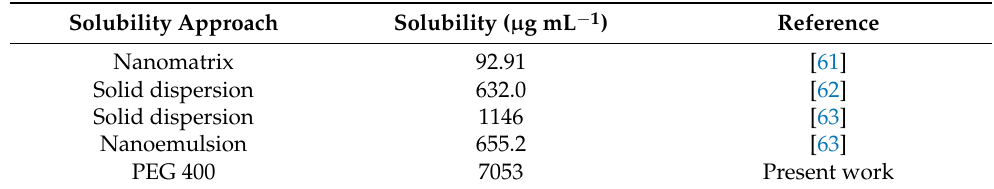
Table 3. Comparison of current solubility data of FTX in PEG 400 with different approaches of FXT solubility enhancement at 298.2 K.